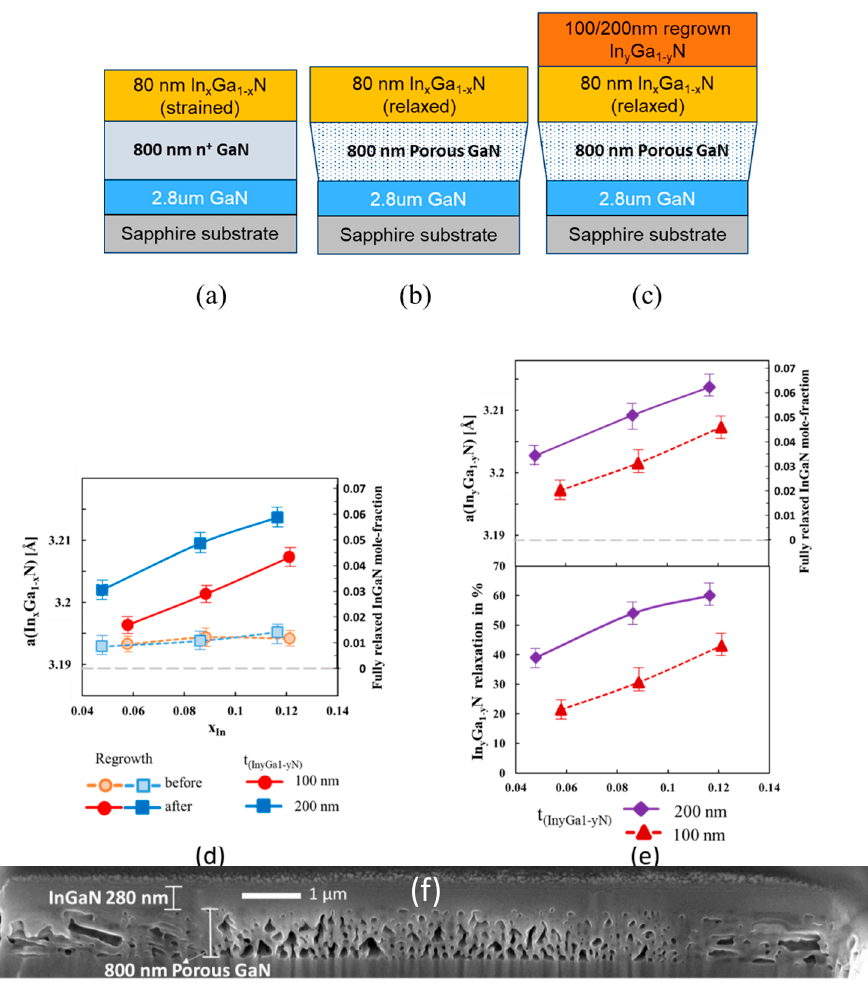
Figure 3. Epitaxial structure of samples with In x Ga 1 − x N layer thickness of 80 nm, with varying mole-fraction x ( a ) as-grown–samples B,C and D, ( b ) post porosification—sample B0,C0 and D0, ( c ) upon regrowth of 100 nm of In y Ga 1 − y N—samples B1, C1 and D1, and upon regrowth of 200 nm InGaN—samples B2,C2 and D2, ( d ) Lattice constant ‘a’ and corresponding In mole fraction of fully relaxed InGaN with the same lattice constant, after porosification, (open symbols, before regrowth, samples B0, C0 and D0), and after regrowth of 100 (filled circles, samples B1, C1, and D1) or 200 nm In y Ga 1 − y N (filled squares, samples B2, C2, and D2), versus mole fraction x in the as-grown In x Ga 1 − x N layers. Grey dashed line corresponds to the ‘a’ lattice constant of GaN, ( e ) (top plot) Lattice constant ‘ a ’ in angstrom, and corresponding mole fraction of a fully relaxed InGaN layer versus mole-fraction x of as-grown In x Ga 1 − x N layers, after regrowth of 100 (triangles) or 200 nm In y Ga 1 − y N layers (rhombi), (bottom plot). Degree of relaxation of In y Ga 1 − y N layers, versus mole-fraction of In x Ga 1 − x N layers, after regrowth of 100 (triangles) or 200 nm In y Ga 1 − y N layers (rhombi). Grey dashed line corresponds to the ‘a’ lattice constant of GaN, ( f ) Cross-sectional focused ion-beam SEM image of a 10 µ m × 10 µ m tile cleaved through the centre, for the sample C2 (200 nm In y Ga 1 − y N regrown on 80 nm of In x Ga 1 − x N, where x = 0.09 and y =